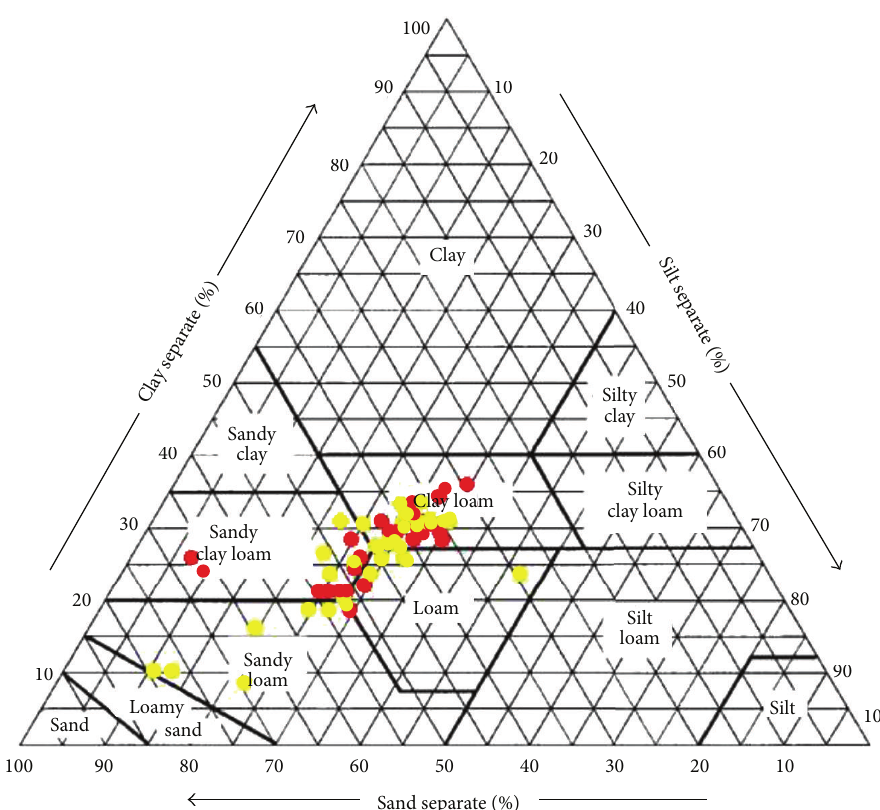
Figure 2: Distributions of the subsurface soil texture of study area before (red dot) and after (yellow dot) land leveling.